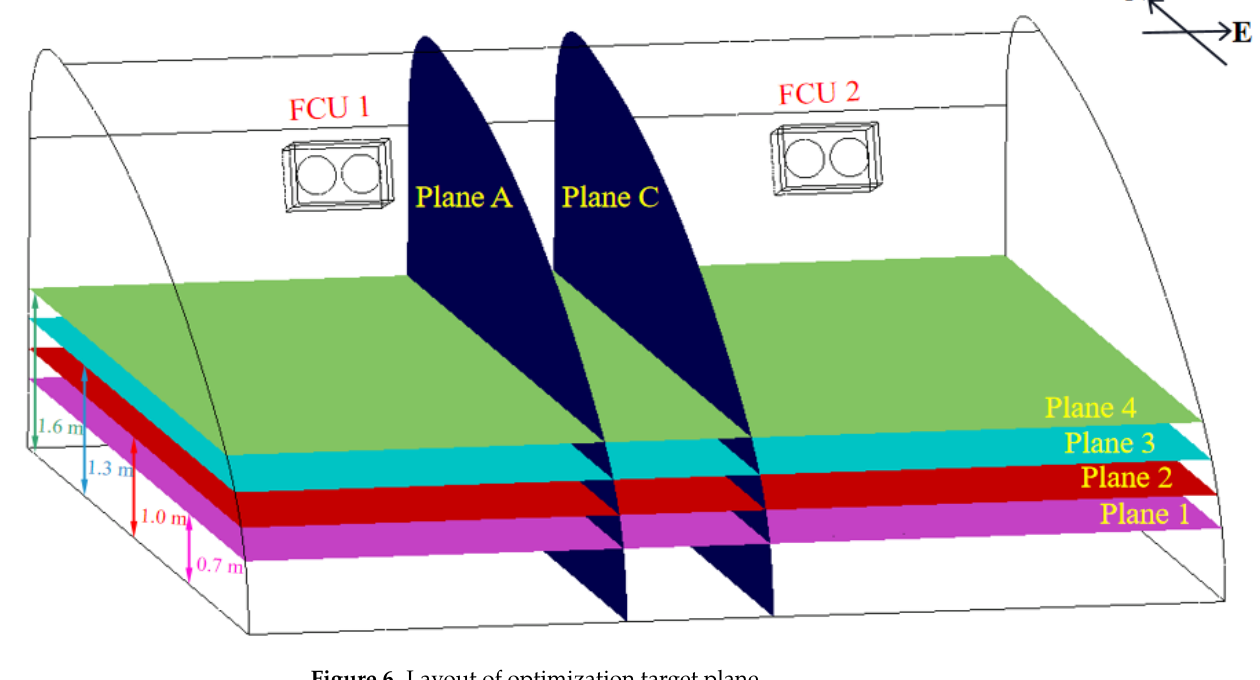
Figure 6. Layout of optimization target plane.